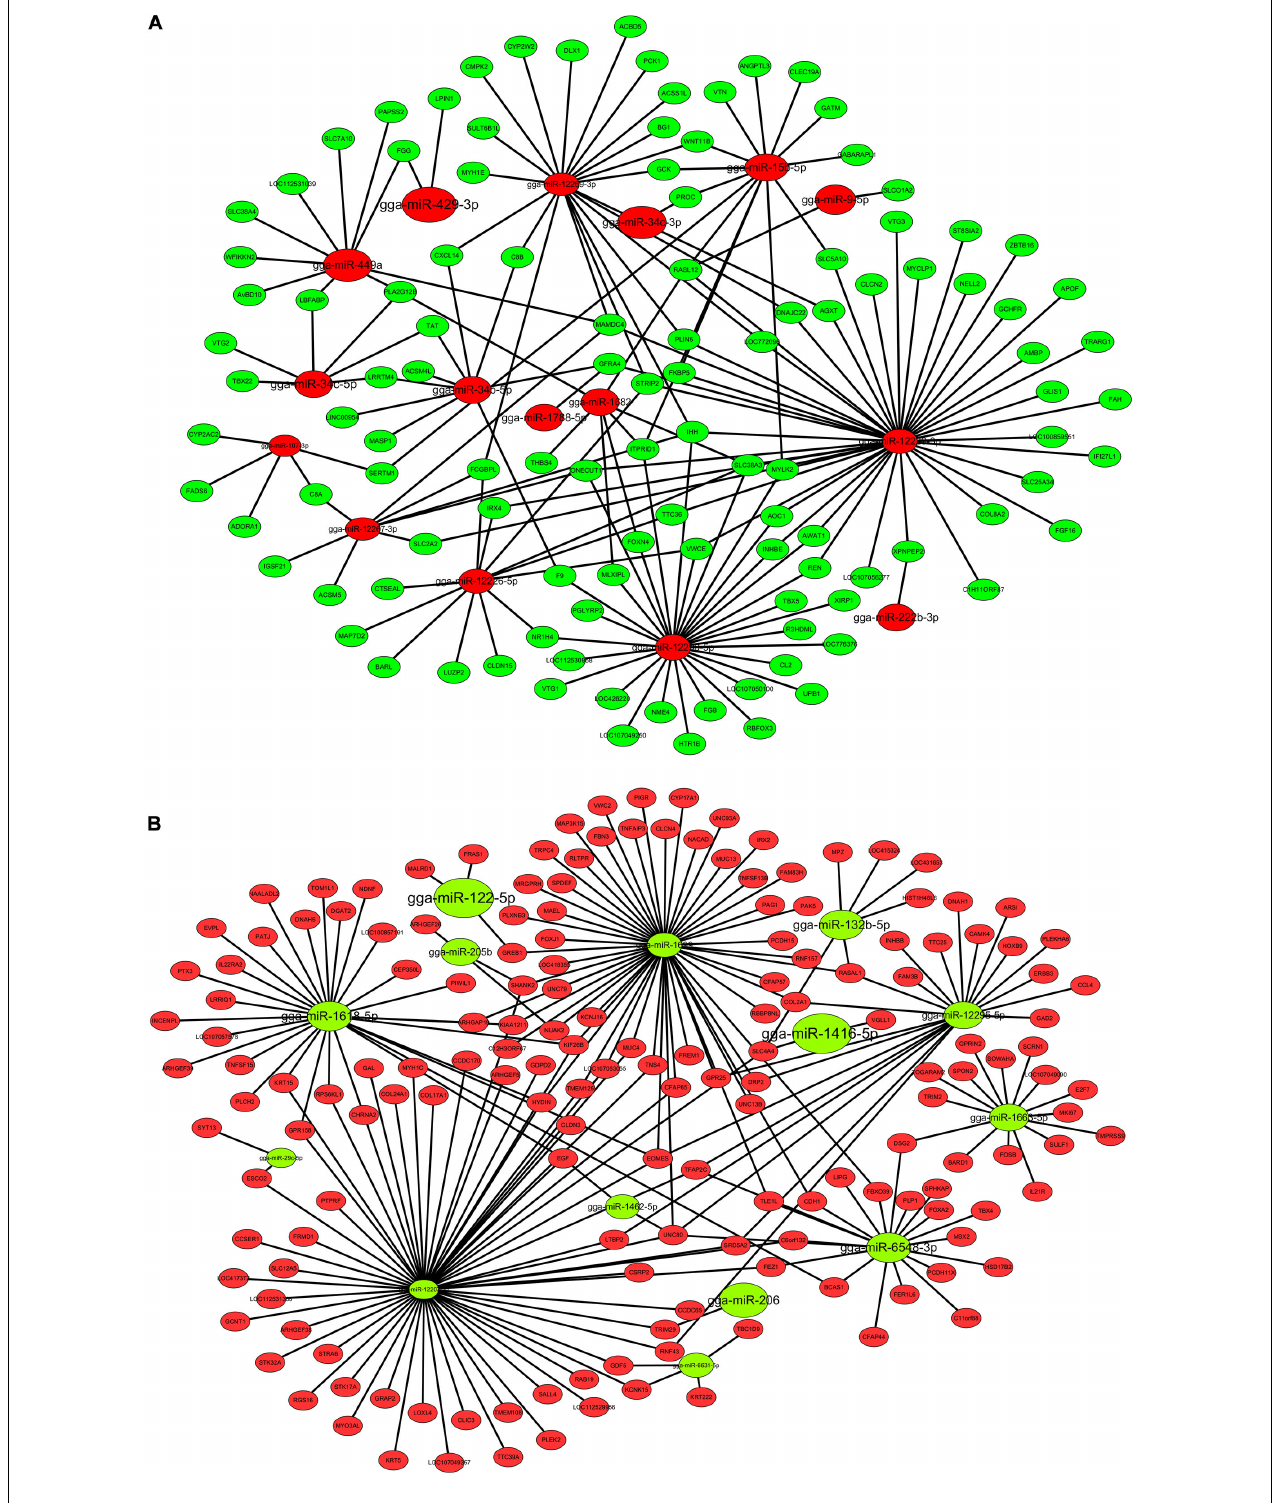
FIGURE 3 | DEMs-DEGs interaction networks. (A) The interaction network between up-regulated DEMs and down-regulated DEGs. (B) The interaction network between down-regulated DEMs and up-regulated DEGs. The pattern size of DEMs was determined by miRNA abundance the pattern size of DEGs is uniform.